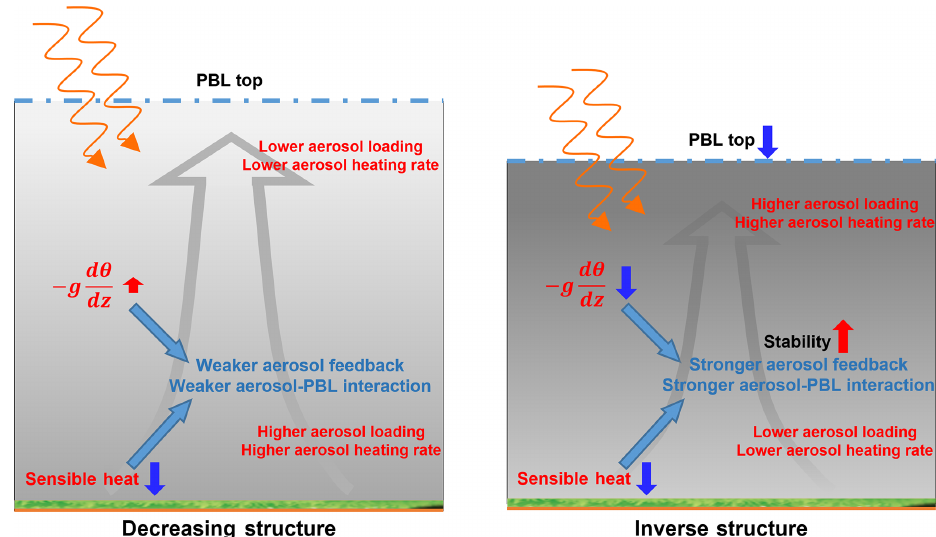
Figure 9. Schematic diagrams describing aerosol–PBL interactions when decreasing and inverse aerosol structures are present. The blue dash-dotted line indicates the top of the PBL. Orange curved arrows indicate solar radiation. The background grey arrow sketches the vertical transport of humidity, aerosols, and heat. The background greyscale indicates the pollution